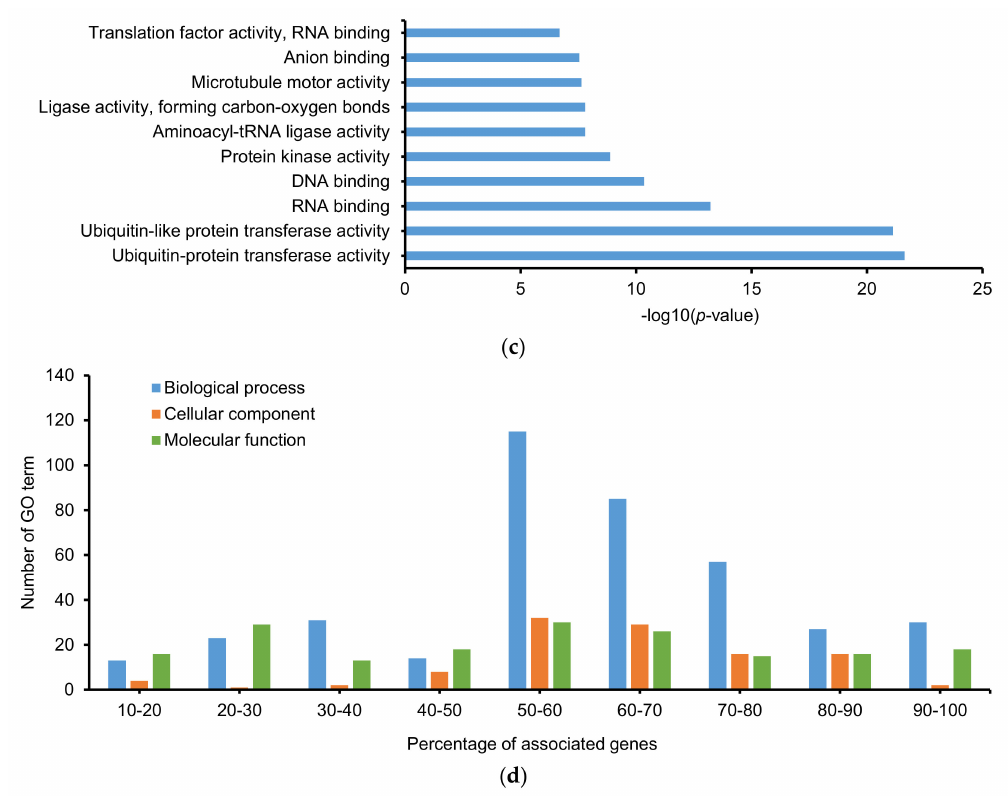
Figure 5. Gene ontology (GO) analysis of identified protein groups from E. huxleyi (CCMP371) using ClueGO. Top 10 of ( a ) biological processes, ( b ) cellular components, and ( c ) molecular functions regarding − log10( p -value). ( d ) Summary of GO term number according to % associated